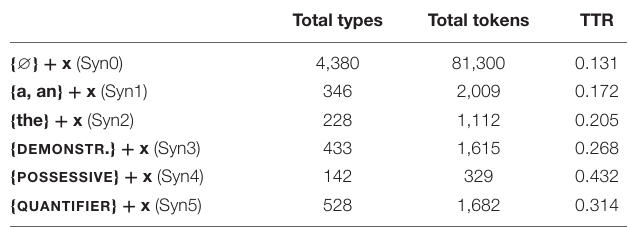
TABLE 6 | Total of non-nouns in each of the distributional contexts. Total